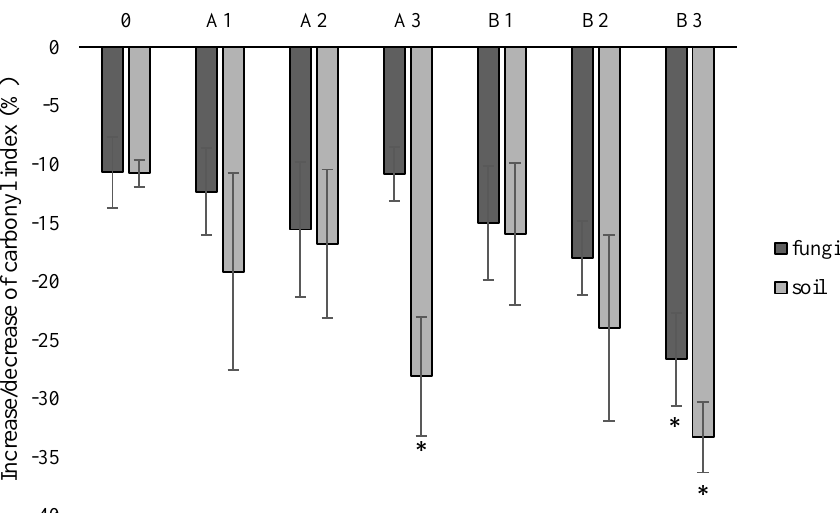
Figure 7. Carbonyl index (%) of samples after incubation with fungi or in soil solution in relation to control samples. *—statistically significant difference based on the one-way ANOVA analysis. Abbreviations: as in Table 2.